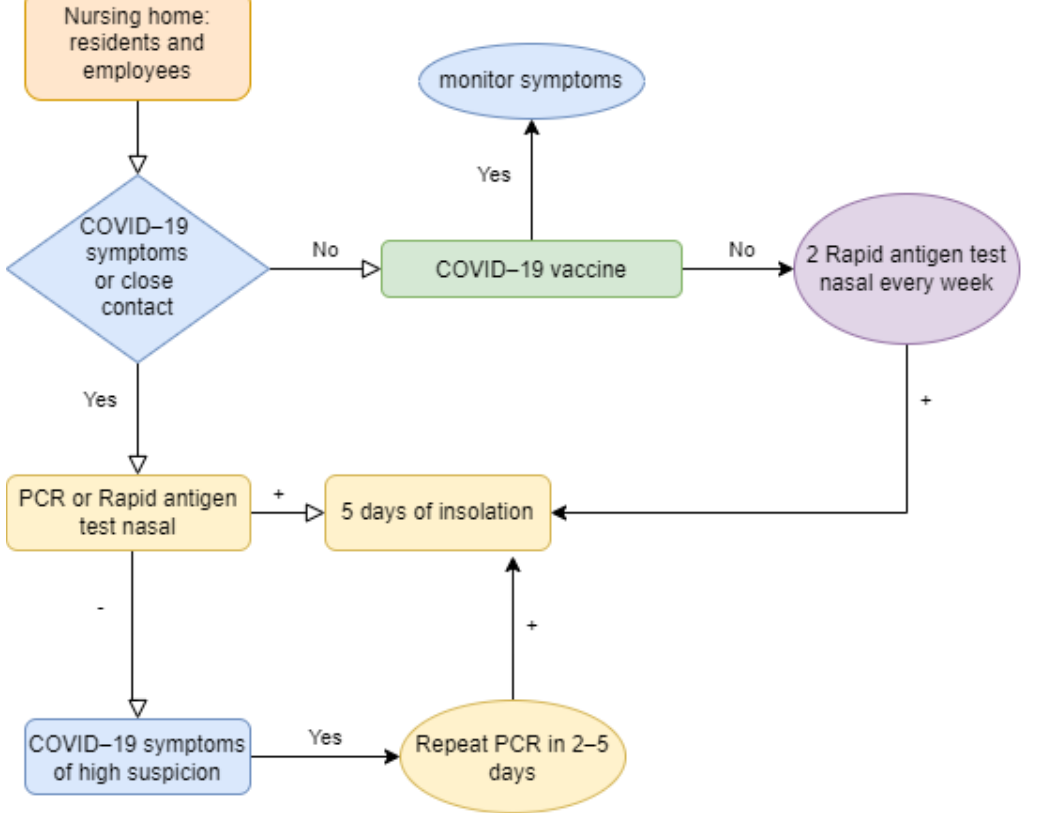
Figure 2. S uspected cases of COVID-19 , r ecommendations of the Spanish Ministry of Health in 2022. Figure 2. Suspected cases of COVID-19, recommendations of the Spanish Ministry of Health in